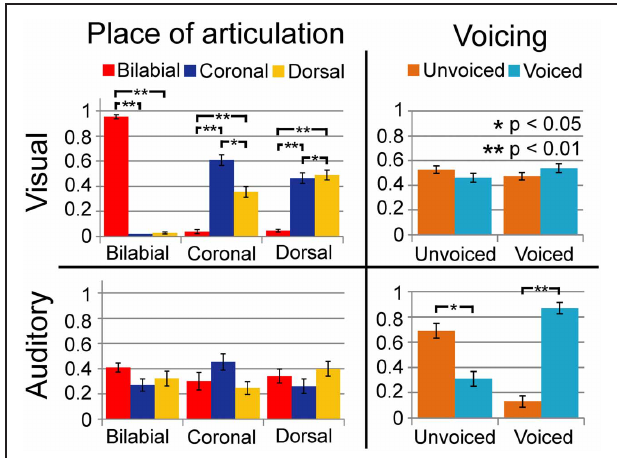
FIGURE 2 | Results of unimodal analyses for auditory and visual signals separately. Horizontal axis represents the category of the stimulus and vertical axis represents the response proportions of the respective categories. Dashed lines indicate chance level performance. As shown, vision can dissociate place of articulation (POA) and audition can dissociate voicing (VC).